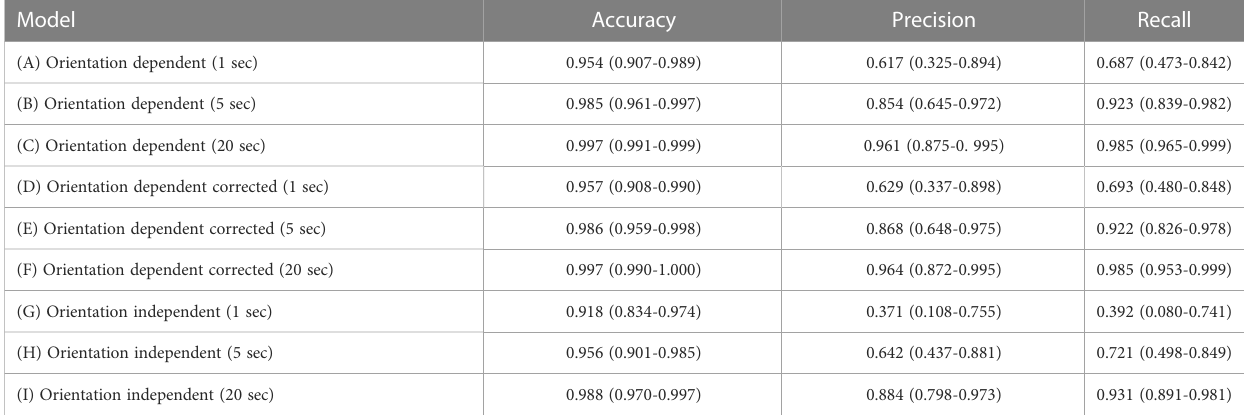
TABLE 2 Overview of the nine models with the average and range for accuracy (as the ratio of correct predictions out of all predictions), precision (as the ratio of true positives over the sum of false positives and true negatives), and recall (as the ratio of correct predicted outcomes to all predictions).